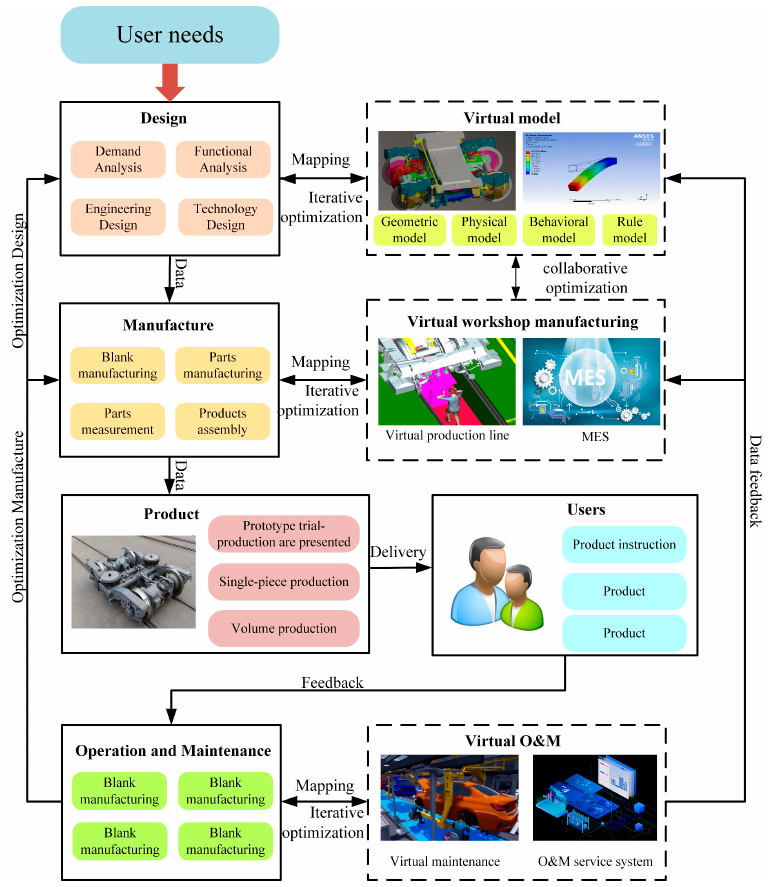
Figure 2. Digital ‐ twin ‐ based complex product design, manufacturing and O&M integration Figure 2. Digital-twin-based complex product design, manufacturing and O&M integration development process. development